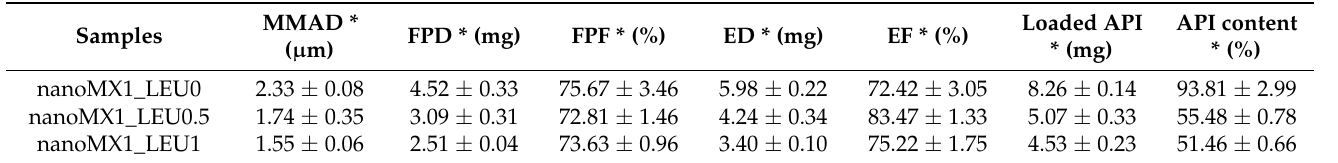
Table 9. In vitro aerodynamic properties of the “nano-in-micro” systems. FPD, fine particle dose; FPF, fine particle fraction; ED, emitted dose; EF, emitted fraction.